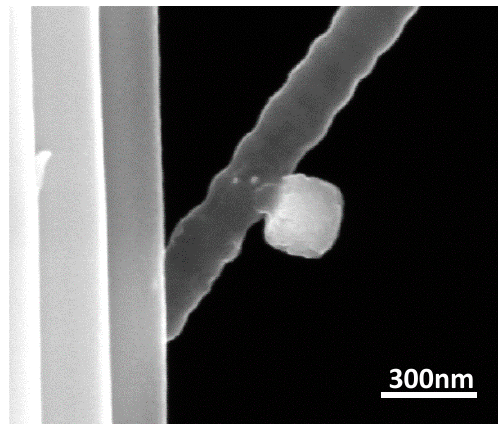
Figure 8. Approximate asymmetric interfacial arrested crack between a copper nanocube and a necked PAN nanofiber at ε = 11%.